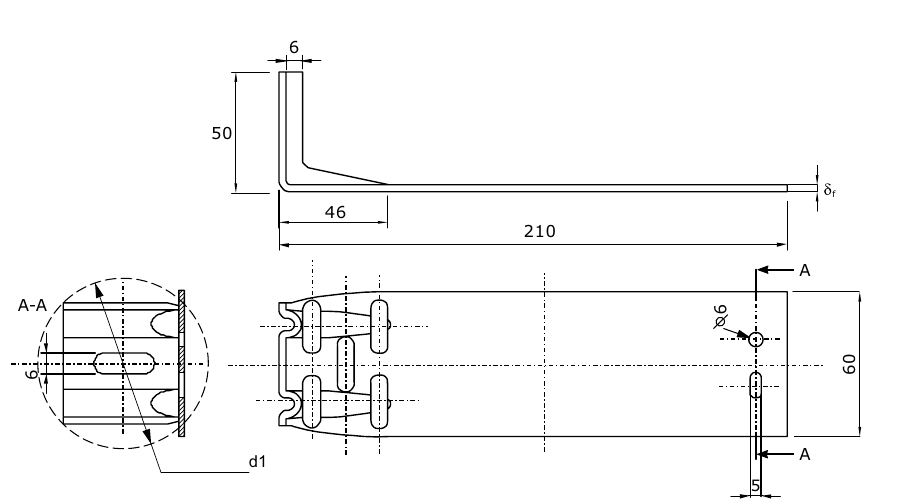
Figure 2. Dimensions of a building fastener for attaching ventilated facades.